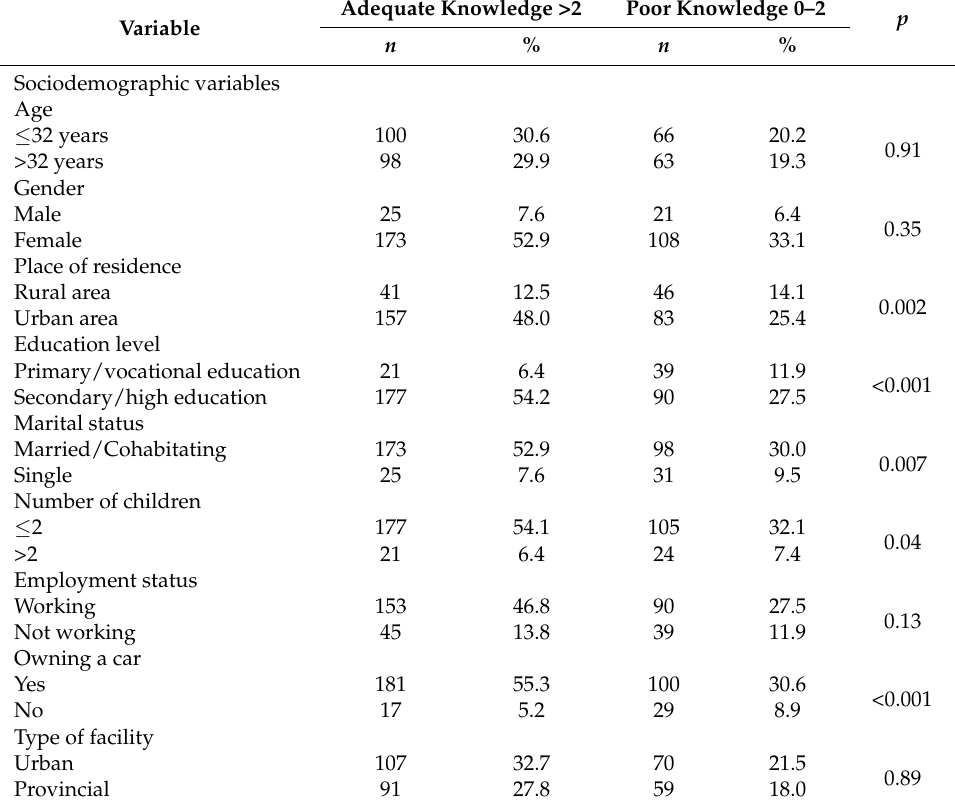
Table 3. Factors influencing the knowledge regarding meningococci by bivariate analysis; Szczecin region, Poland; 2018, n =